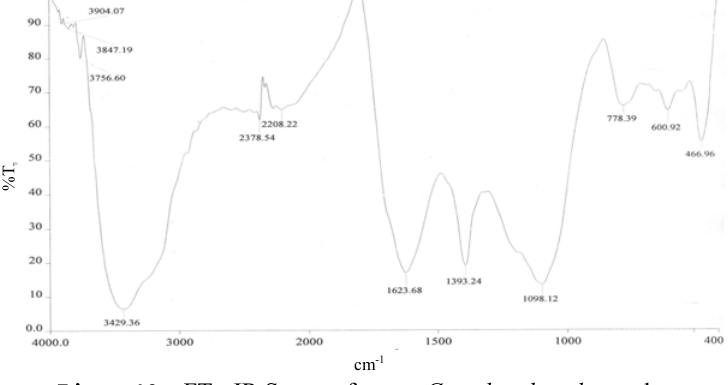
Figure 10a . FT - IR Spectra for raw Cynodon dactylon carbon